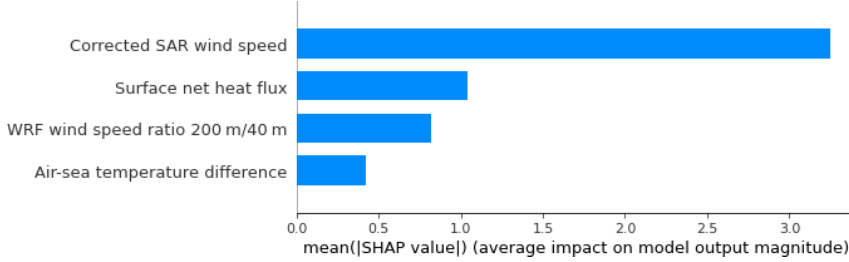
Figure 6. Relative importance of the input parameters used to extrapolate SAR surface winds to higher altitudes.